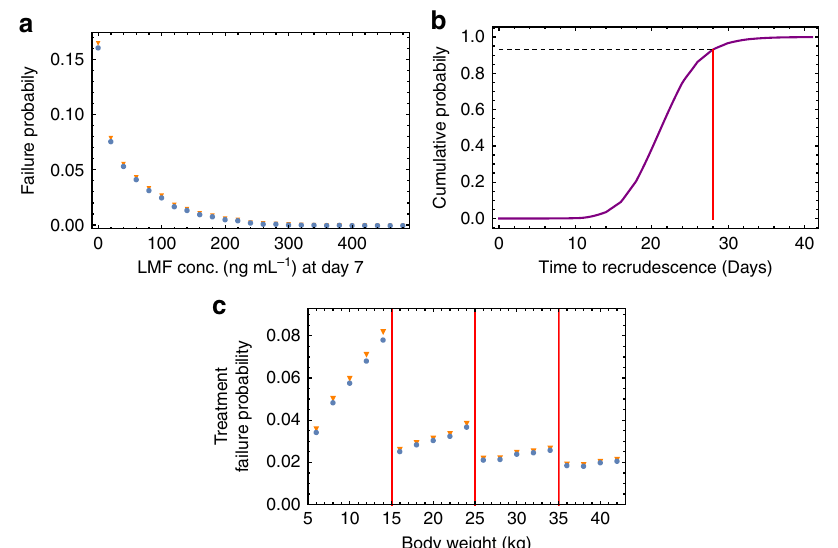
Fig. 2 Details of treatment failure in our within-host model. Here we summarise simulated data generated from the proportion (about 5%) of 10 6 model runs for which treatment failed. a The estimated probability of parasitological treatment failure according to the lumefantrine concentration 7 days after treatment commenced. The proportion failing treatment was calculated from 10 6 model runs, grouping the results into bins of width 20 ng mL − 1 . The blue circles measure treatment failure as positive by microscopy on day 28: the orange triangles show results obtained when an additional follow-up is made on day 42. b The simulated cumulative probability distribution for the time to recrudesce (the time at which parasitaemia becomes detectable by microscopy after treatment failure) in our model. By day 28 (red vertical line), around 93% (black dashed line) of recrudescences are detectable. c Factors in fl uencing treatment failure. The probability of treatment failure according to patient body weight. The vertical red lines indicate the four dosing groups, determining the number of pills per dose (one, two, three, or four). These results were generated by grouping patients into 2 kg-wide bins. The symbols are as described in a